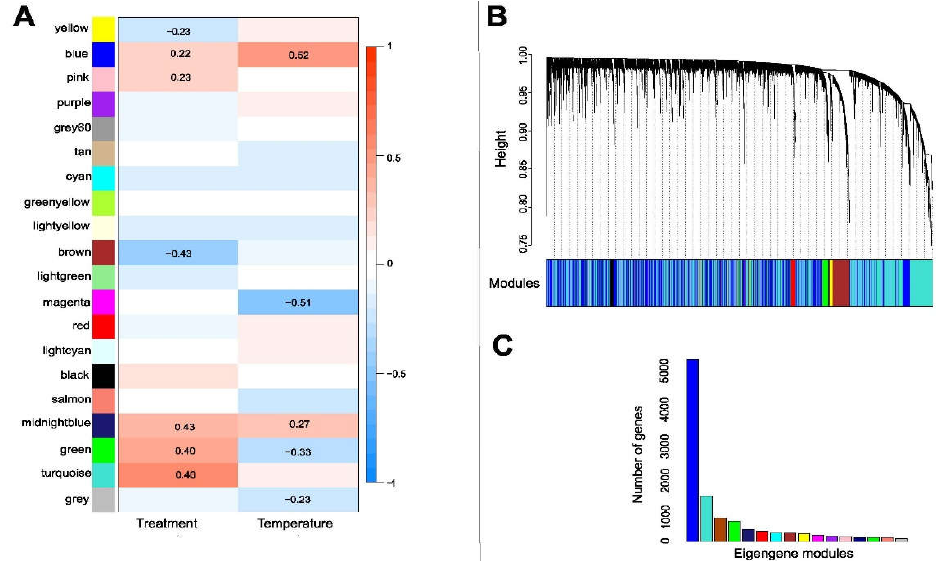
Figure 4. ( A ) Module traits in the mycobiont of Lobaria pulmonaria . The correlation coefficients for each intersection of the corresponding row and column modules are given. The red and blue shades and numbers within the boxes represent –log (P), the correlation coefficient of significant correlations according to the color legend on the right. Modules are represented by the different colors on the left side. There were seven modules associated with antibiotic treatment and five modules associated with temperature ( p < 0.05). ( B ) Co-expression network analysis of different samples in the mycobiont of L. pulmonaria , showing a hierarchical cluster tree of co-expression modules based on WGCNA. Each leaf in the tree corresponds to an individual gene. The branches correspond to modules of highly interconnected genes. The y axis represents the level of intramolecular connectivity, genes that are located at the tip of the module branches have higher interconnectedness with the rest of the genes in the module. The differently colored bars below the dendrograms indicate module membership. ( C ) Number of eigengenes per module, with colors as in ( A , B